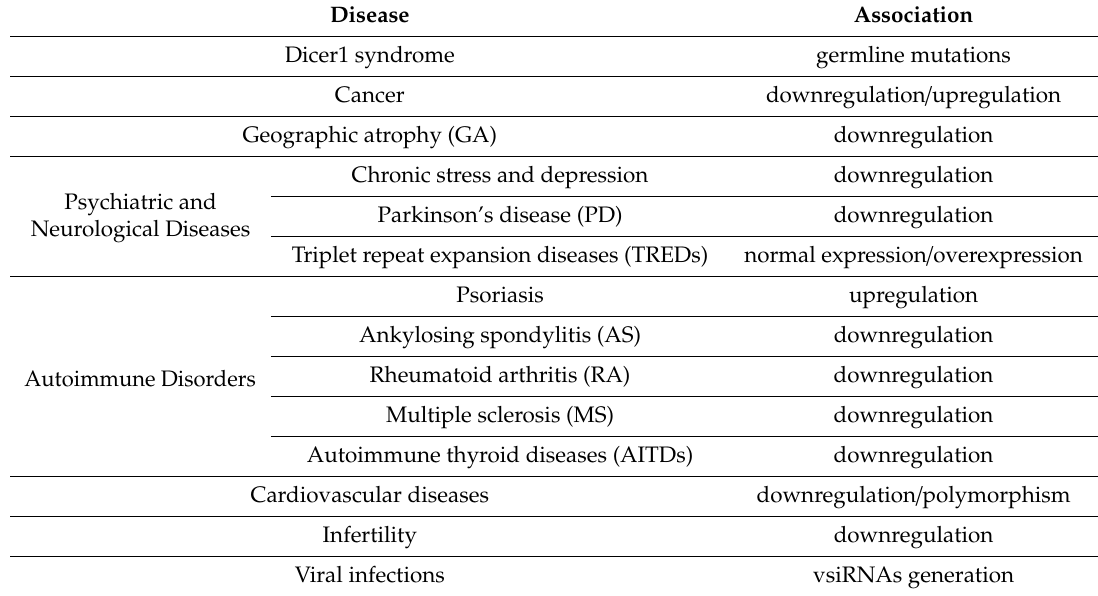
Table 1. The deregulated Dicer expression in associated human